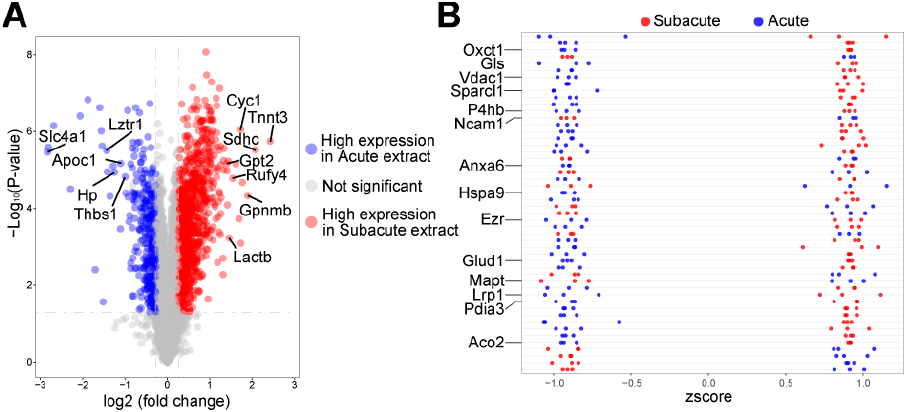
Figure 2. Differently expressed proteins of the acute and subacute brain extracts. Autophagy- related proteins were detected in the TBI microenvironment in the acute and subacute phases ( A , B ).